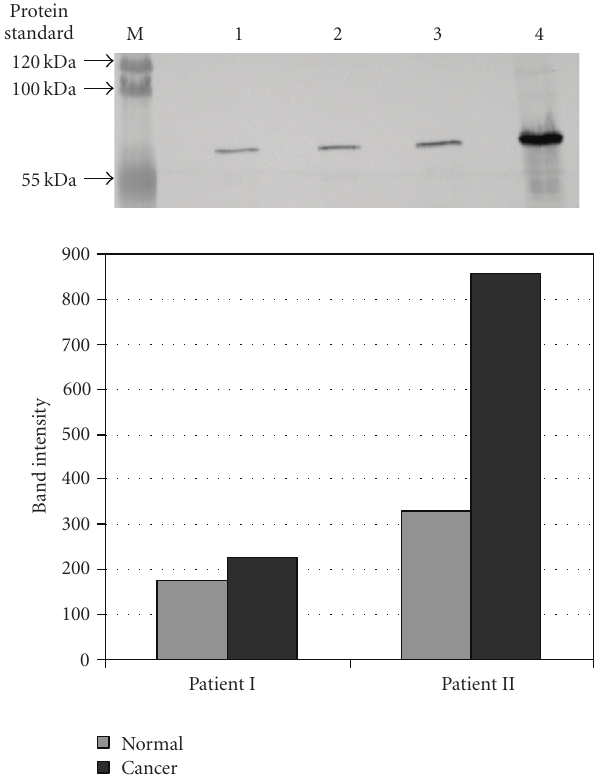
Figure 4: Immunoblot of annexin V. Lane M: protein molecular weight markers (in kDa). Lane 1: normal TRIS extract from first patient. Lane 2: cancer TRIS extract from first patient. Lane 3: normal TRIS extract from second patient. Lane 4: cancer TRIS extract from second